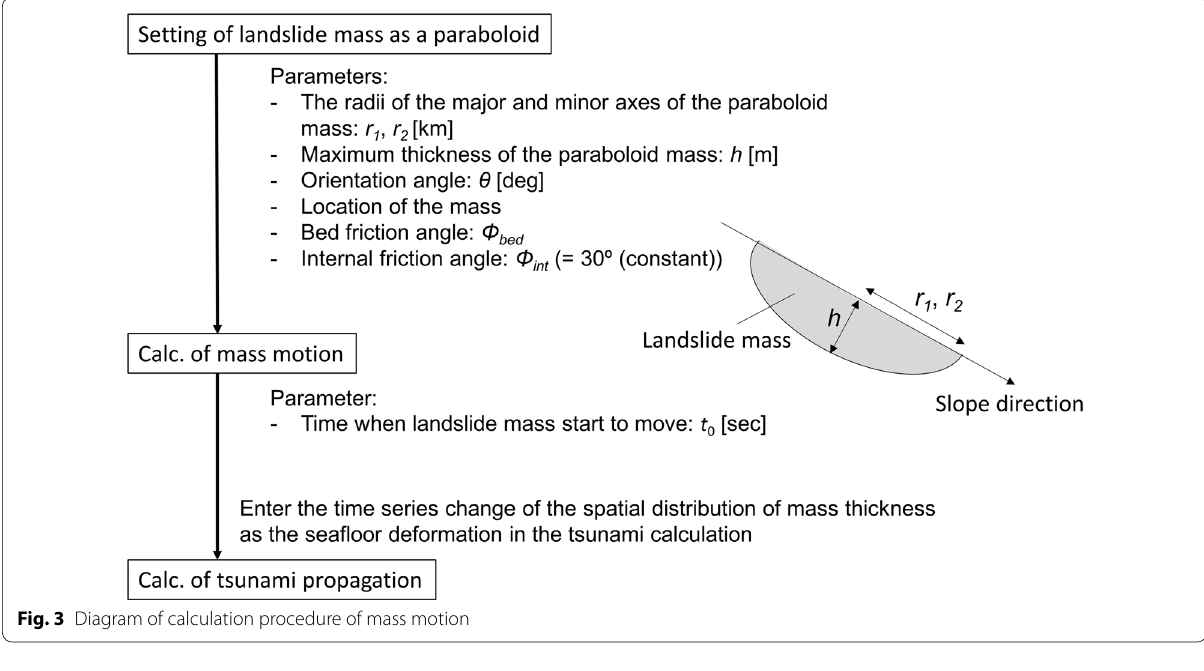
Fig. 3 Diagram of calculation procedure of mass